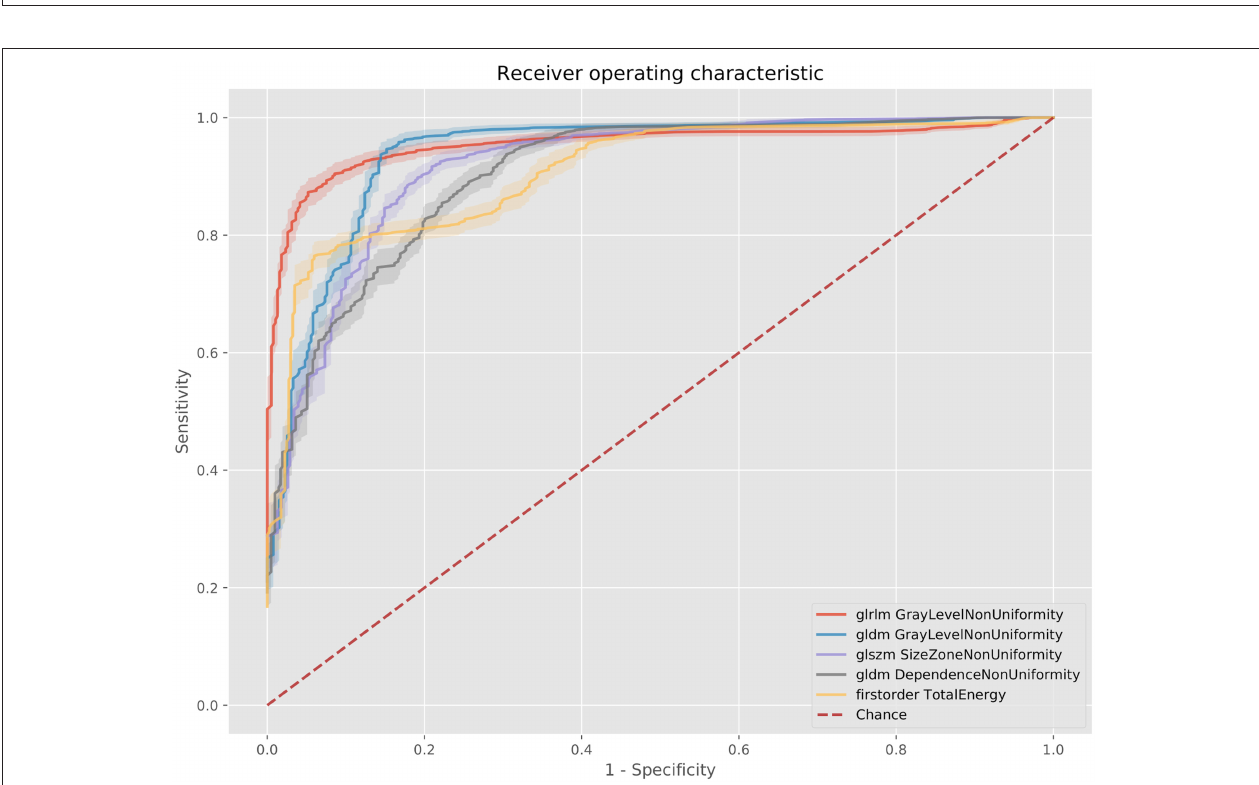
FIGURE 5 | ROC curves for the best 5 AUC values on the 100 kV images. GLDM, Gray level dependence matrix; GLSZM, gray level size zone matrix.